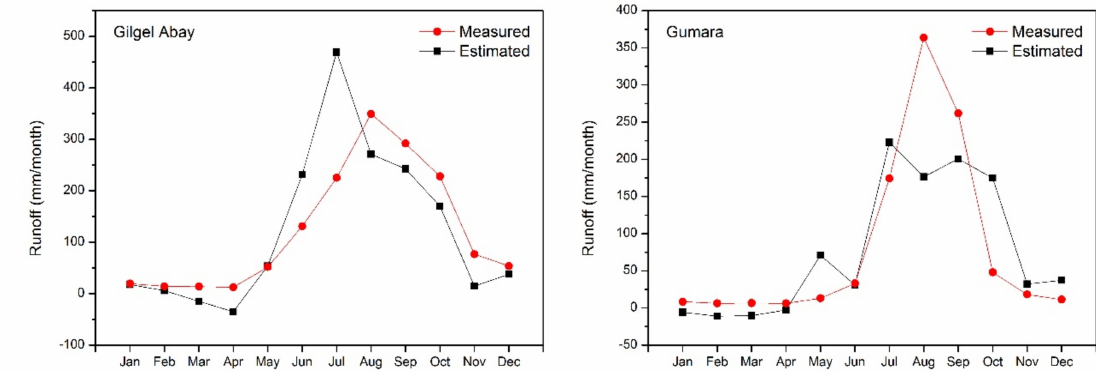
Figure 2. Monthly estimated and measured runoff over two gauged catchments Gilgel Abay and